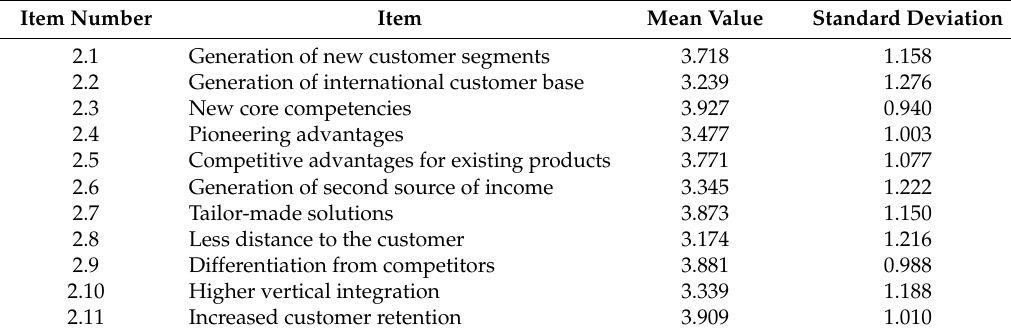
Table A2. Potentials of new business model features for the provider.